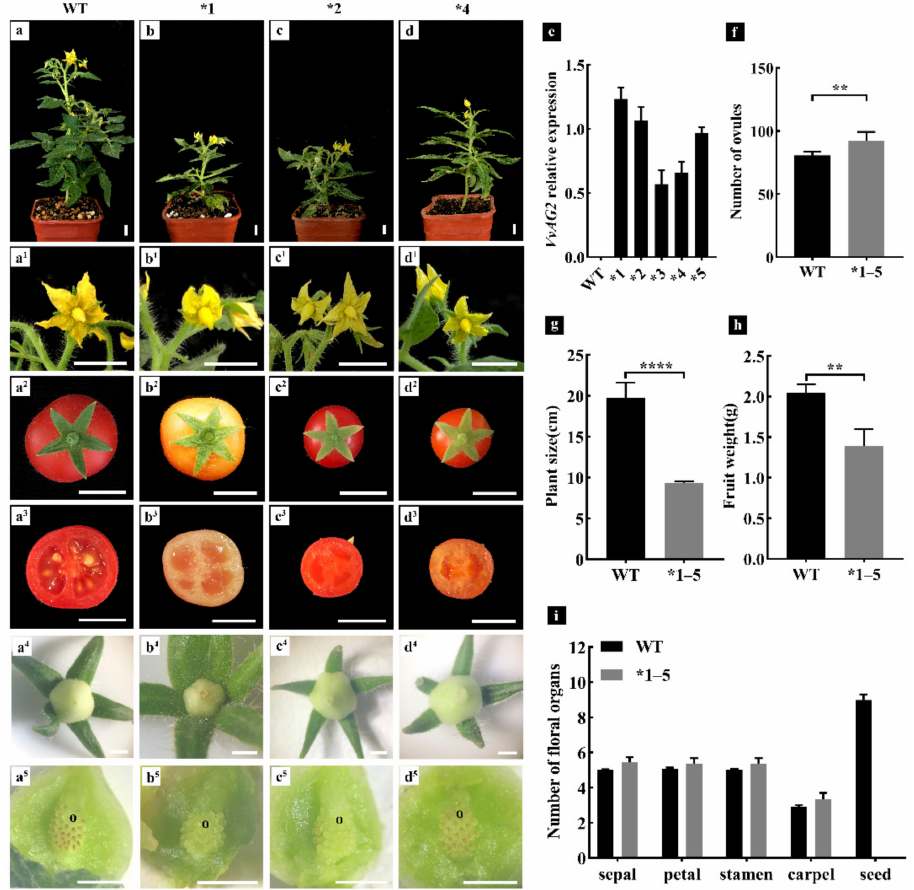
Figure 7. Functional analysis of transgenic tomato plants expressing VvAG2 . ( a , a 1 – a 3 ) Wild-type Micro-Tom plant, flower and fruit organs. Scale bars = 1 cm. ( b – d ) Independent transgenic lines expressing VvAG2 plant. ( b 1 – b 3 , c 1 – c 3 , d 1 – d 3 ) Flower and fruit organs of transgenic lines, scale bars = 1 cm. ( a 5 , b 5 , c 5 , d 5 ) Ovules in one locule of young fruit ( a 4 , b 4 , c 4 , d 4 , one week after anthesis), scale bars = 1 mm. ( e ) VvAG2 relative expression of wild-type and transgenic plants *1–5. ( f – h ) Ovules number, plant size and fruit weight in wild-type and transgenic plants. ( i ) The number of floral organs in wild-type and transgenic plants. o, ovule primordia. Error bars indicate standard errors. Values are mean ± standard errors. Significance analysis was conducted with two-tailed Student’s t -tests (** p < 0.01, **** p <